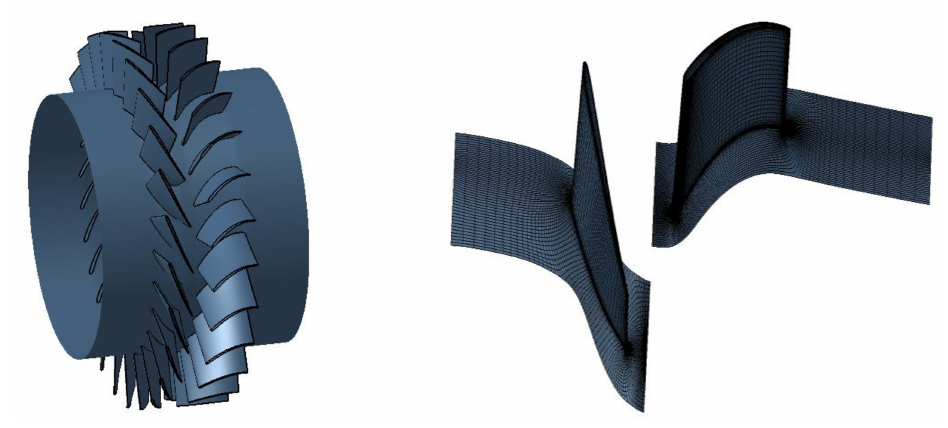
Figure 6. First stage geometry and